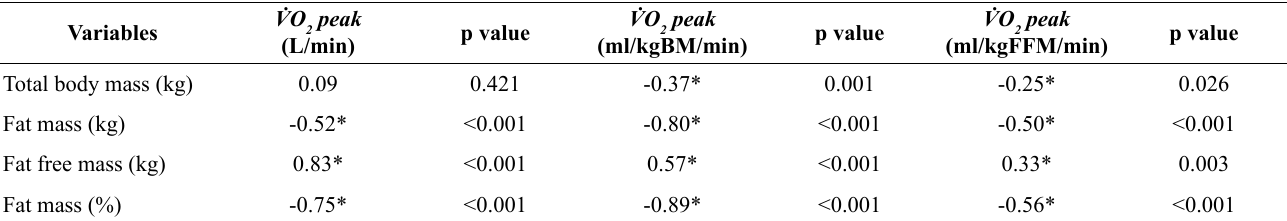
Table 2. Pearson coefficient correlation values between and body composition variables (n=80).